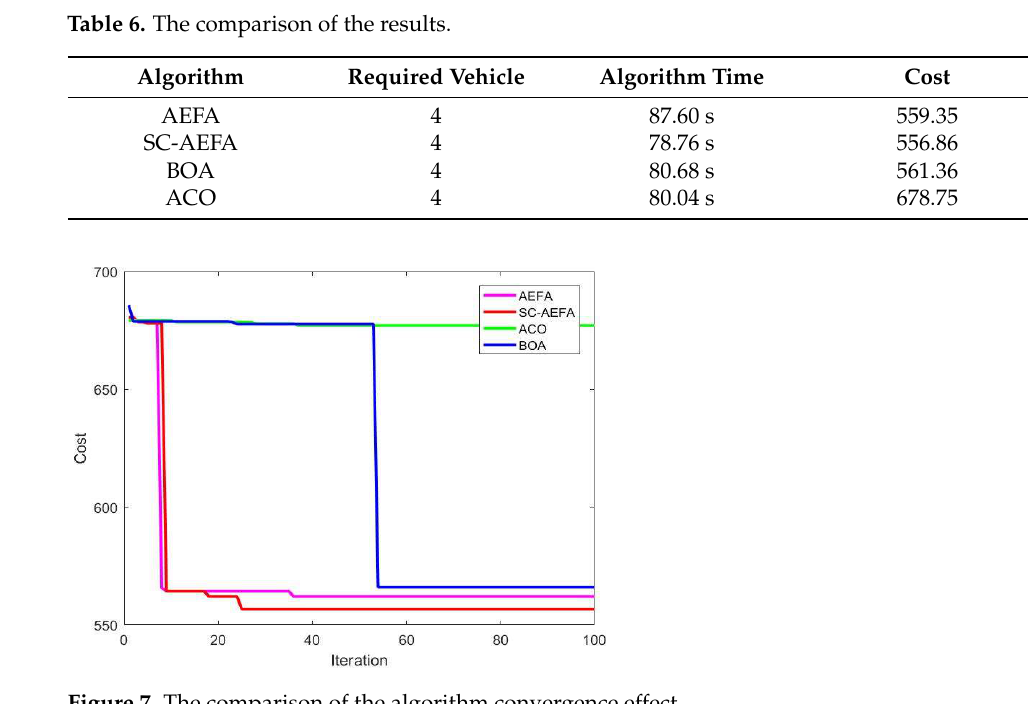
Table 5. The customer and distribution center node details.